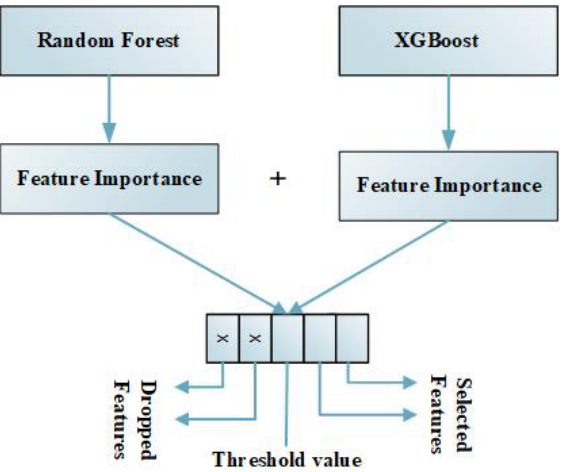
Figure 3. Feature-selection and extraction